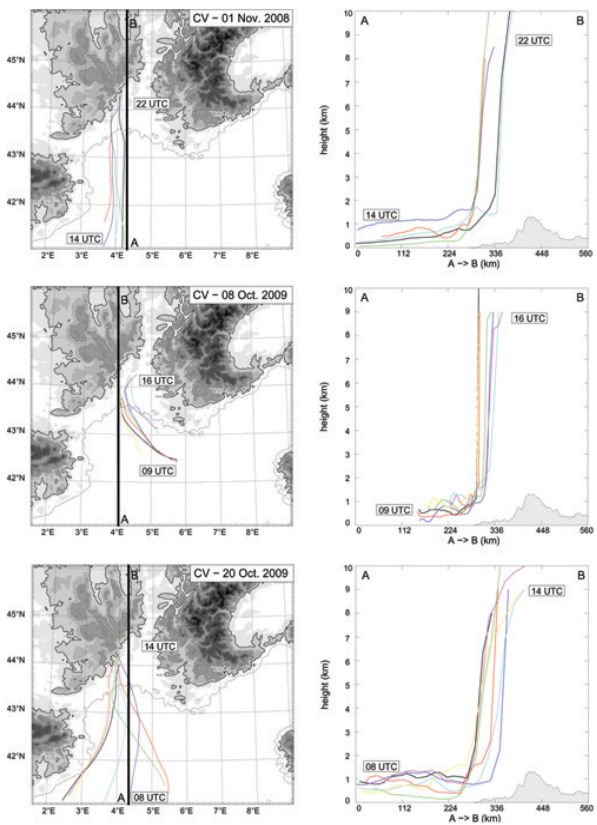
Fig. 8. Same as Fig. 7 for the last three CV cases, the 1 November 2008 (top), the 8 October 2009 (middle) and the 20 October 2009 (bottom).